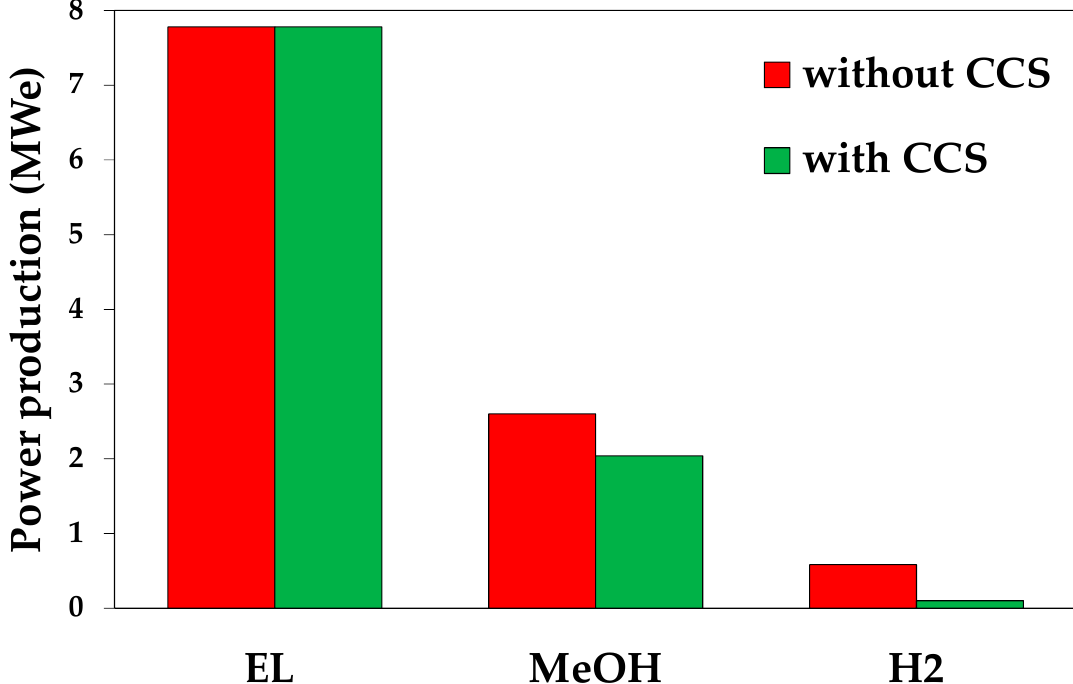
Figure 6. ElectricpowerproductionforEL,MeOH,andH 2 cases. Calculationbase: 100kt / Figure 6. Electric power production for EL, MeOH, and H 2 cases. Calculation base: 100 kt/year of digestate.